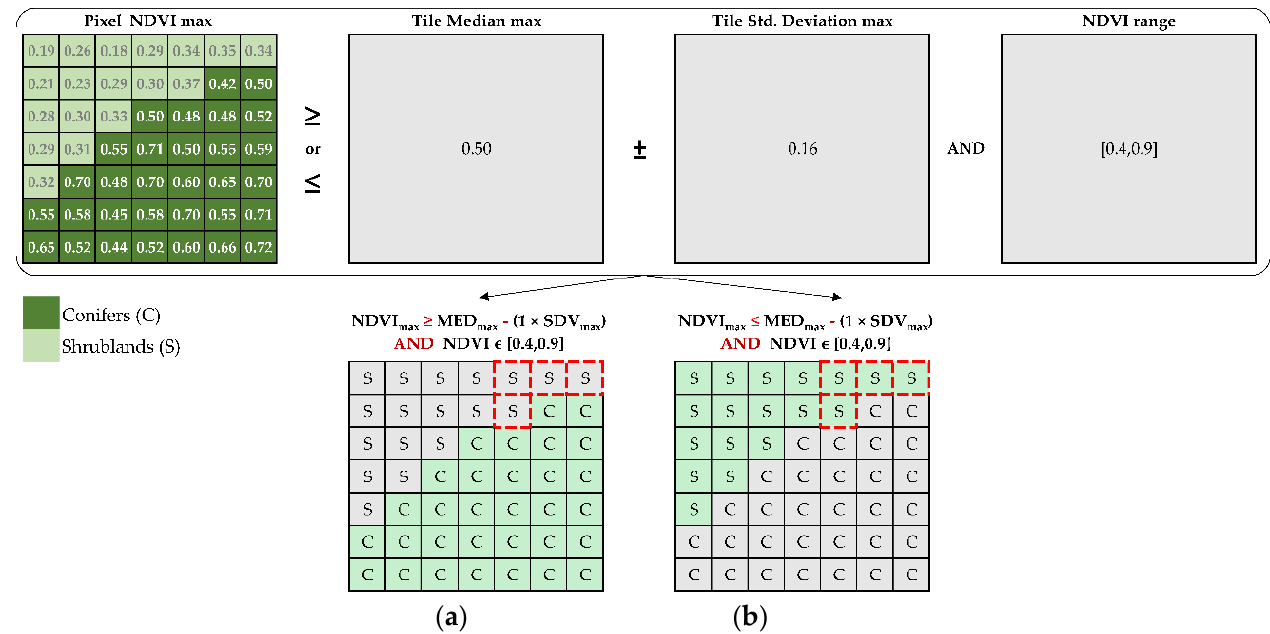
Figure 11. Rule 1 and 2 applied to a tile polygon. Transitional locations (red squares) in ( a ) and ( b ) with anomalous NDVImax values are correctly selected using Rule 2 restrictions.